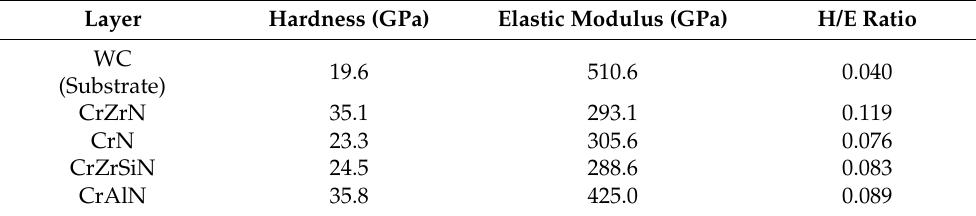
Figure 3. ( a ) Friction curve and ( b ) wear rate of the CrAlN coatings with three interlayers. Table 2. Hardness, elastic modulus, and H/E ratio of the WC substrate; the CrZrN, CrN, and CrZrSiN interlayers; and the CrAlN coating.